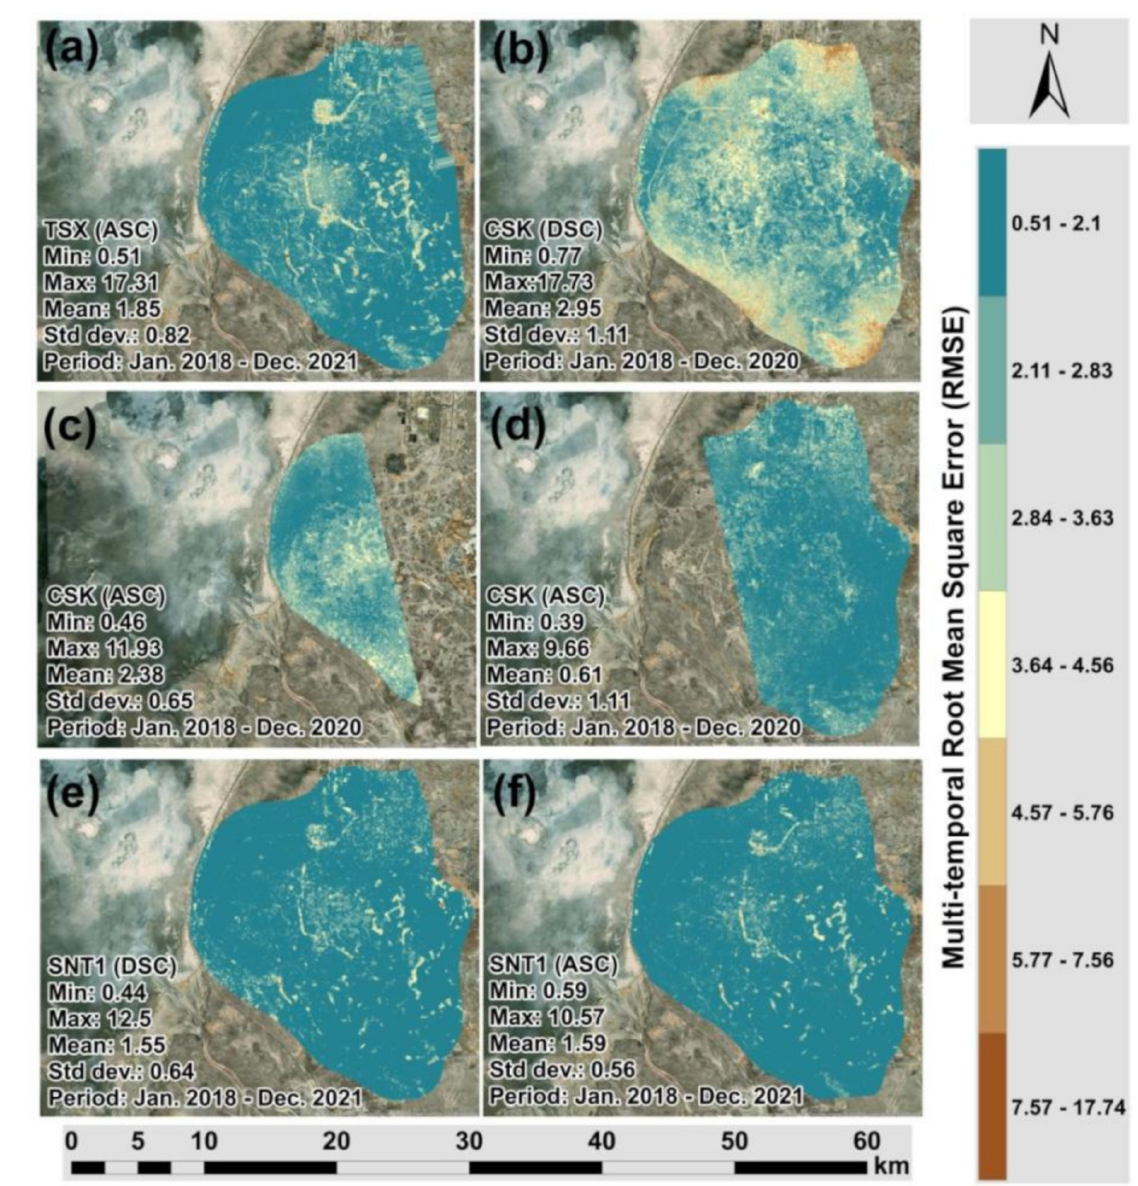
Figure 8. Multi-temporal Root Mean Square Error: ( a ) TSX (ASC Track); ( b ) CSK (DSC Track); ( c ) CSK (ASC Track 1); ( d ) CSK (ASC Track 2); ( e ) SNT1 (DSC Track); ( f ) SNT1